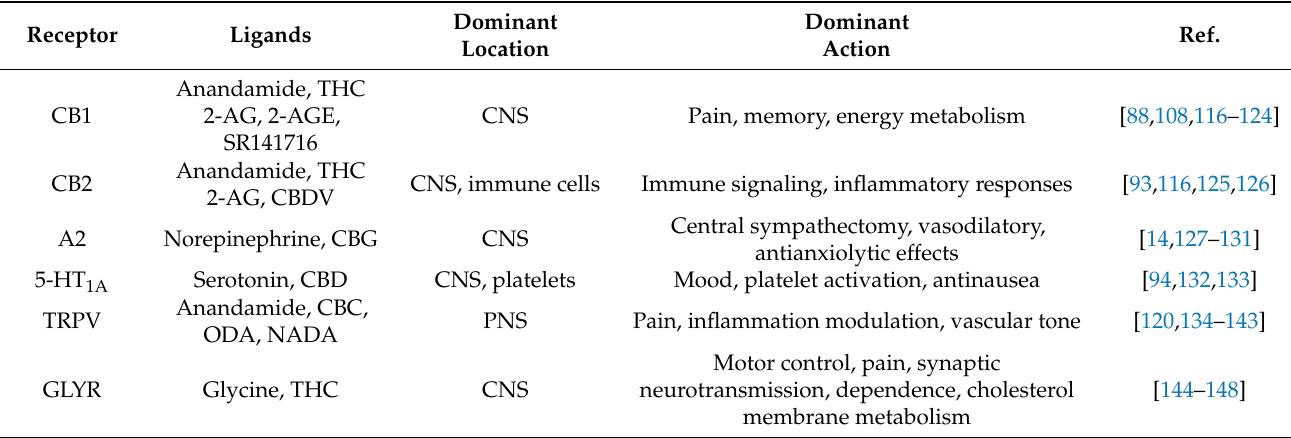
Table 2. Cannabinoid receptors, agonists, locations, and actions in